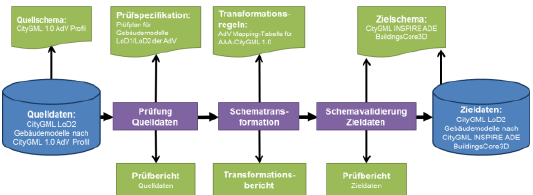
Figure 7. Concept of schematic transformation of 3D Building Models to